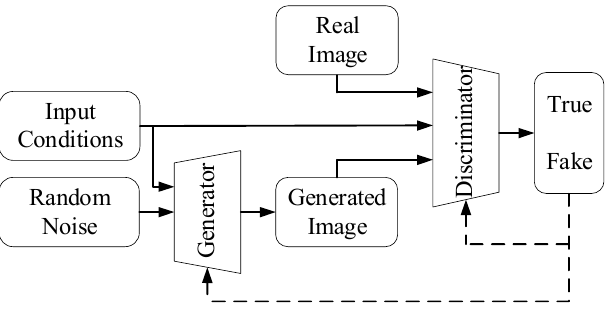
Figure 3. The structure of CGAN.